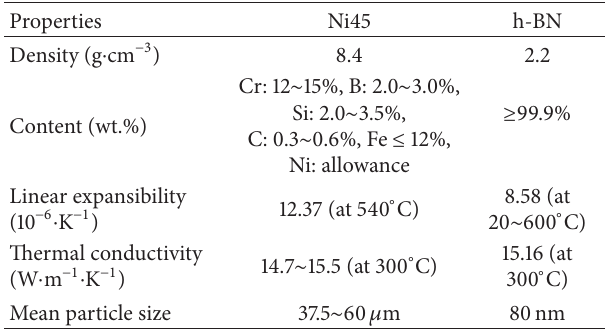
Table 1: Properties of the original powders for HVOF spraying.